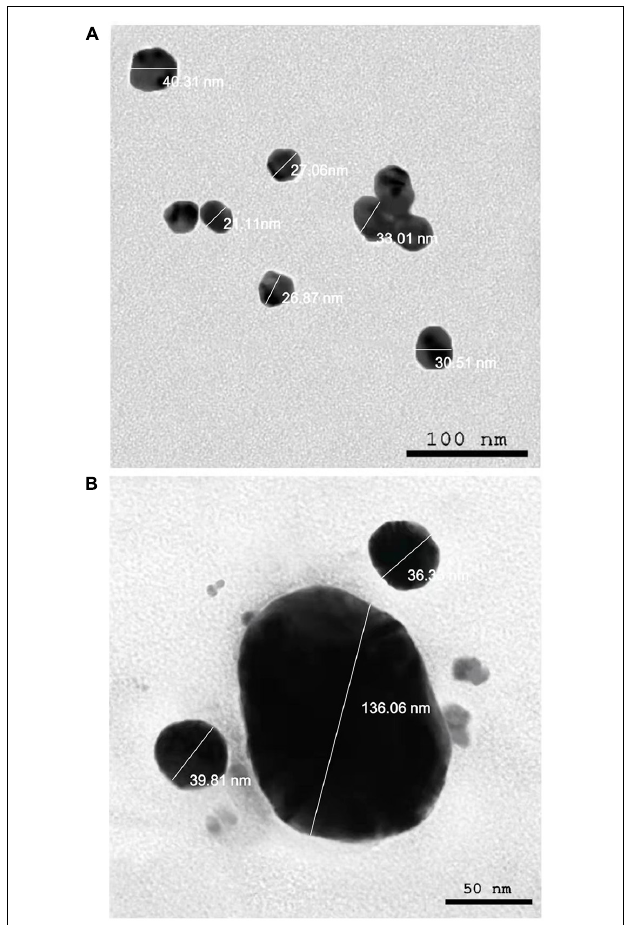
FIGURE 8 | Transmission electron microscopy images of the Nocardiopsis dassonvillei M1-derived Bio-AgNPs. (A) In aqueous solution. (B) In DMEM culture medium.